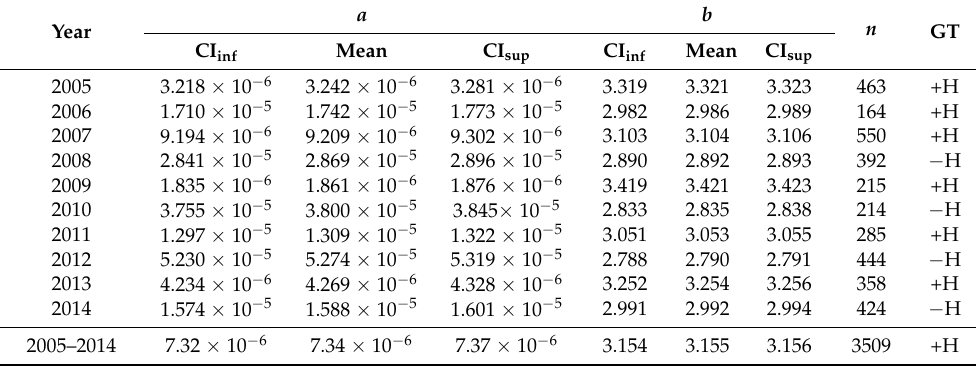
Table 2. Average values and 95% confidence intervals (CI; α = 0.05) of parameters a and b obtained by adjusting the potential model for each year from 2005 to 2014, including all data (average) of the temperate Sardinops sagax stock and growth type (GT; +H, hyper-allometry; − H, hypo-allometry).